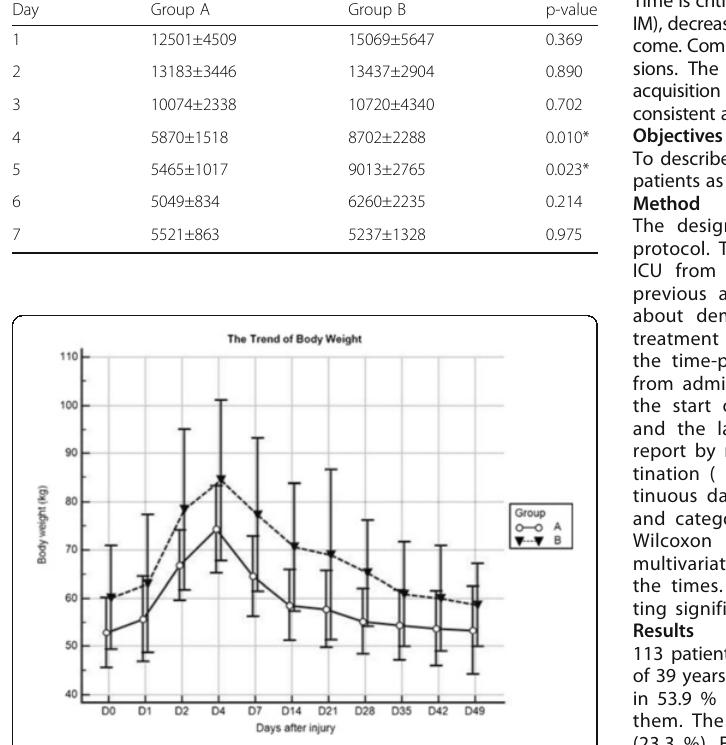
Fig. 114 (abstract A299). The trend of body weight